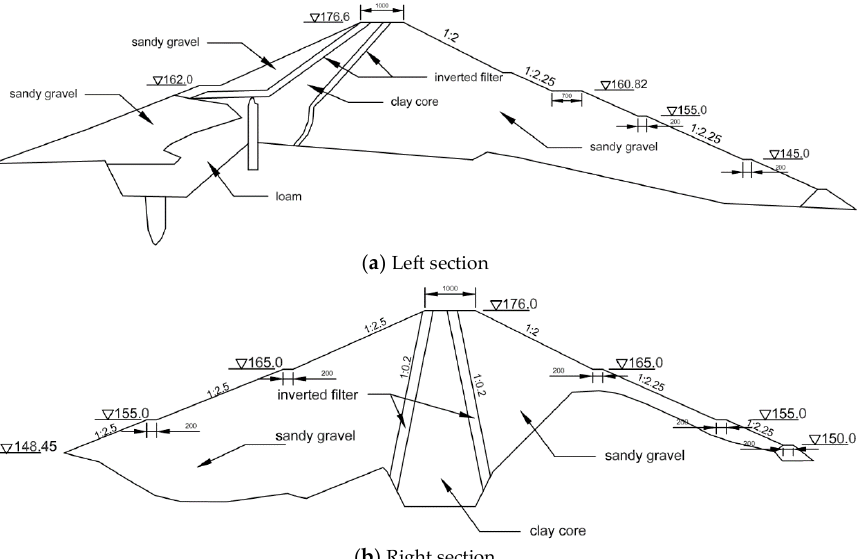
Figure 2. The diagrams of the earth-rock structure (Unit: cm for the structure and m for the elevation).